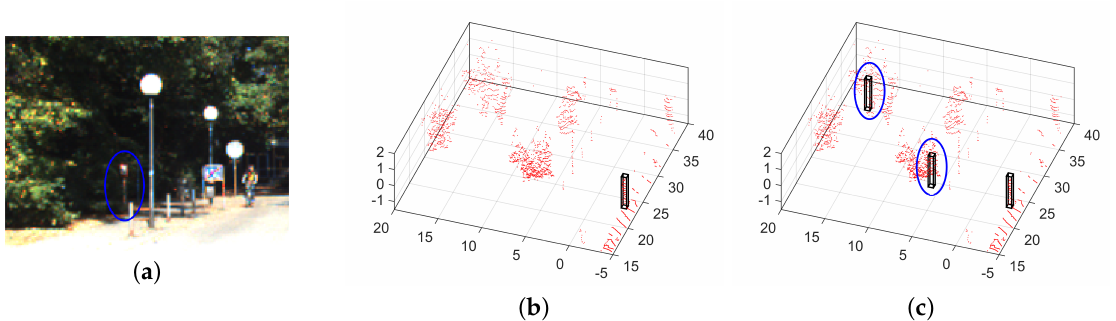
Figure 10. Detection results of objects that may cause false alarms. ( a ) Scenario optical image. ( b ) Detection results with single template matching. ( c ) Detection result with the KDE-based method.